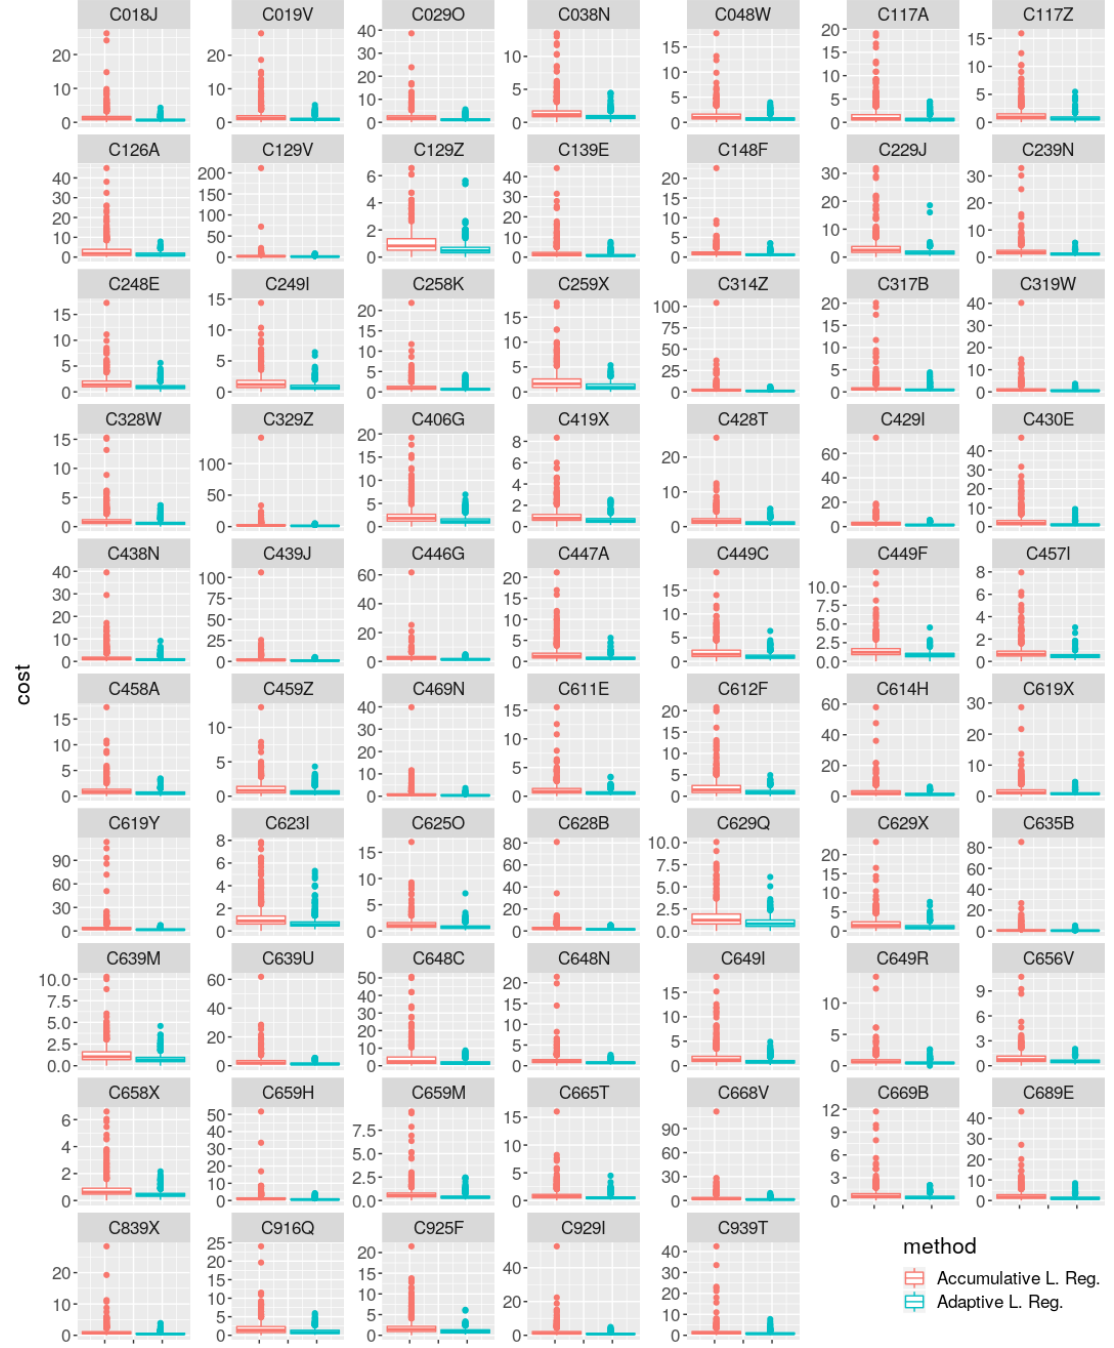
Figure 6. Cost (mean squared error (MSE), (m/s) 2 ) box-plot comparison between both methods for each weather